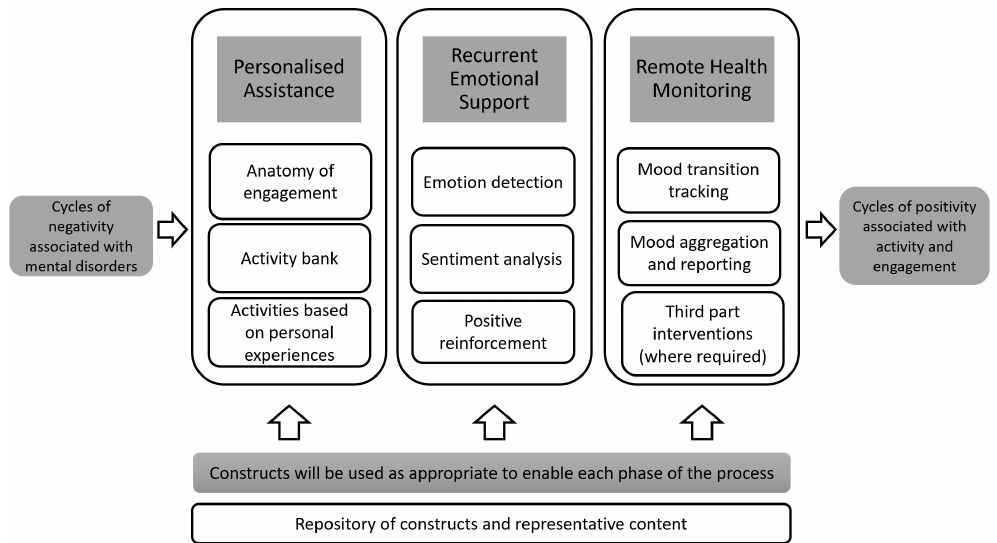
Figure 1. Conceptual framework of behavioural activation in an AI based